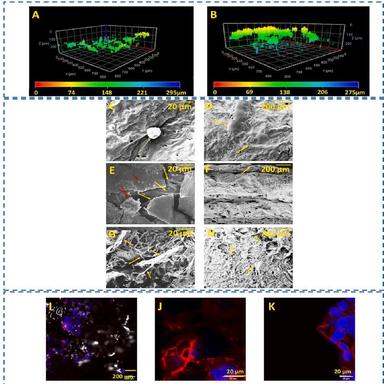
The 3D reconstructions of the tested biomaterials showing the depth of cells penetration into the patches for (A) 5P(3HO) and (B) 5P(3HO)/Dic-oligo(3HAs); SEM microphotographs show (C) the surface of 5P(3HO) at day 1 of the proliferation assay; (D) the surface and (E–F) a cross-section of 5P(3HO) at day 14 of the proliferation assay; (G–H) the surface of 5P(3HO)/Dic-oligo(3Has)-Chem at day 14 of the proliferation assay. Yellow arrows indicate HaCaT, while red ones indicate unleached NaCl. The photographs pr